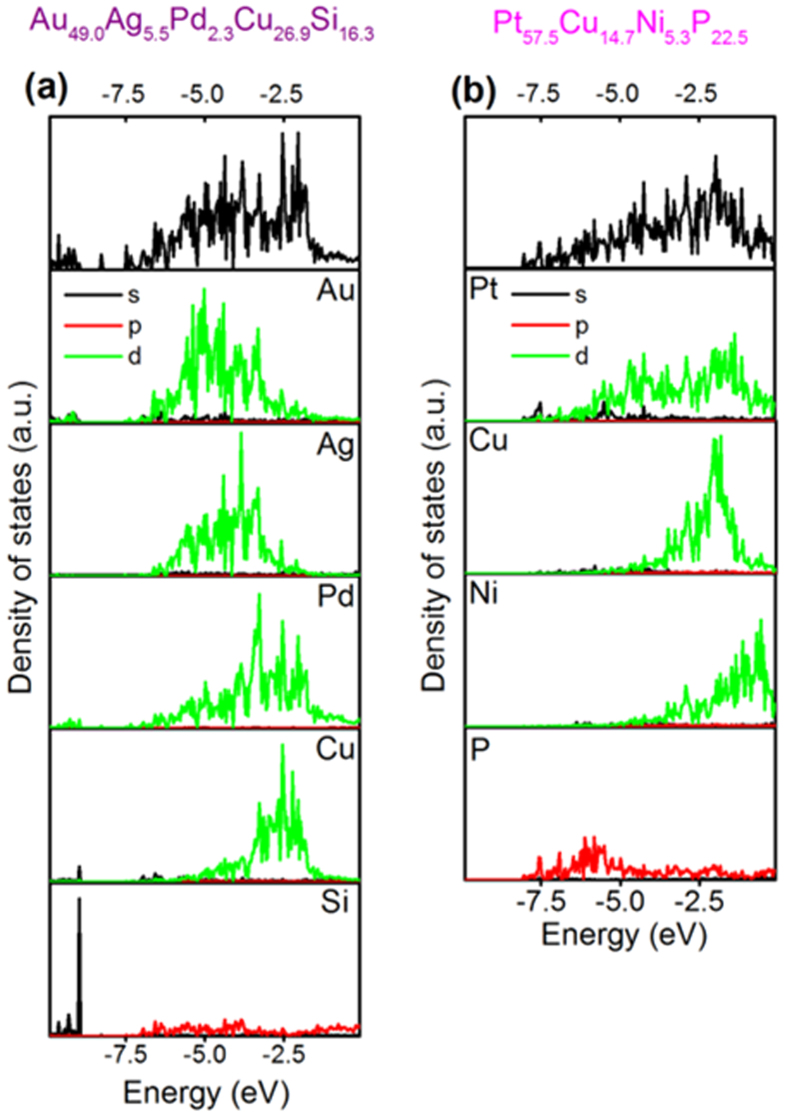
Total and partial density of states for the Au49Ag5.5Pd2.3Cu26.9Si16.3 and Pt57.5Cu14.7Ni5.3P22.5 bulk metallic glasses.(a) Density of states analysis for the Au49Ag5.5Pd2.3Cu26.9Si16.3 metallic glass, including partial density of states for Au, Ag, Pd, Cu and Si. (b) Density of states analysis for the Pt57.5Cu14.7Ni5.3P22.5 metallic glass, including partial density of states for Pt, Cu, Ni and P.